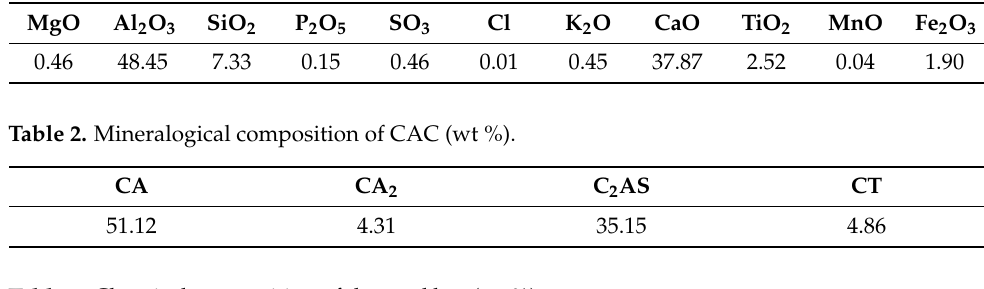
Table 3. Chemical composition of the steel bar (wt %).